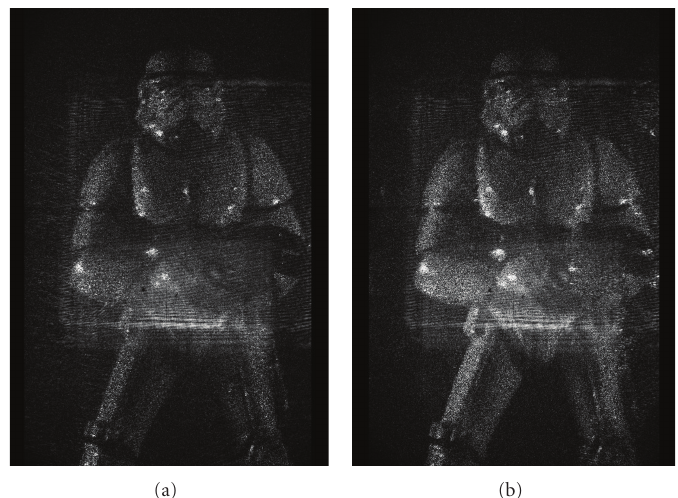
Figure 15: Optoelectronic reconstruction from phase of real object beam obtained with: (a) numerical method of real object beam filtering from single hologram, (b) 4 frames PSI technique of real object beam filtering.